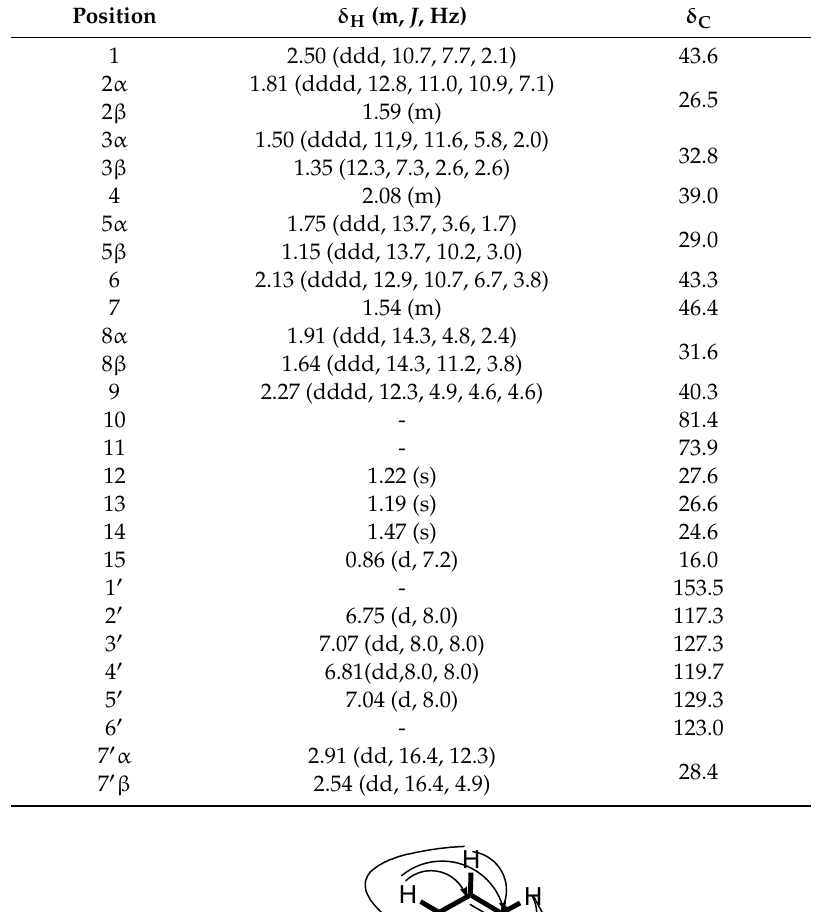
Table 1. 1 H (800 MHz) and 13 C (400 MHz) NMR spectroscopic data for cleistonol ( 1 ) acquired in CDCl 3 .